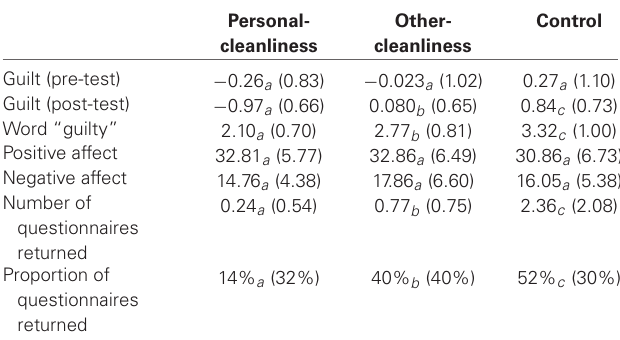
Table 1 | Means of dependent variables as a function of